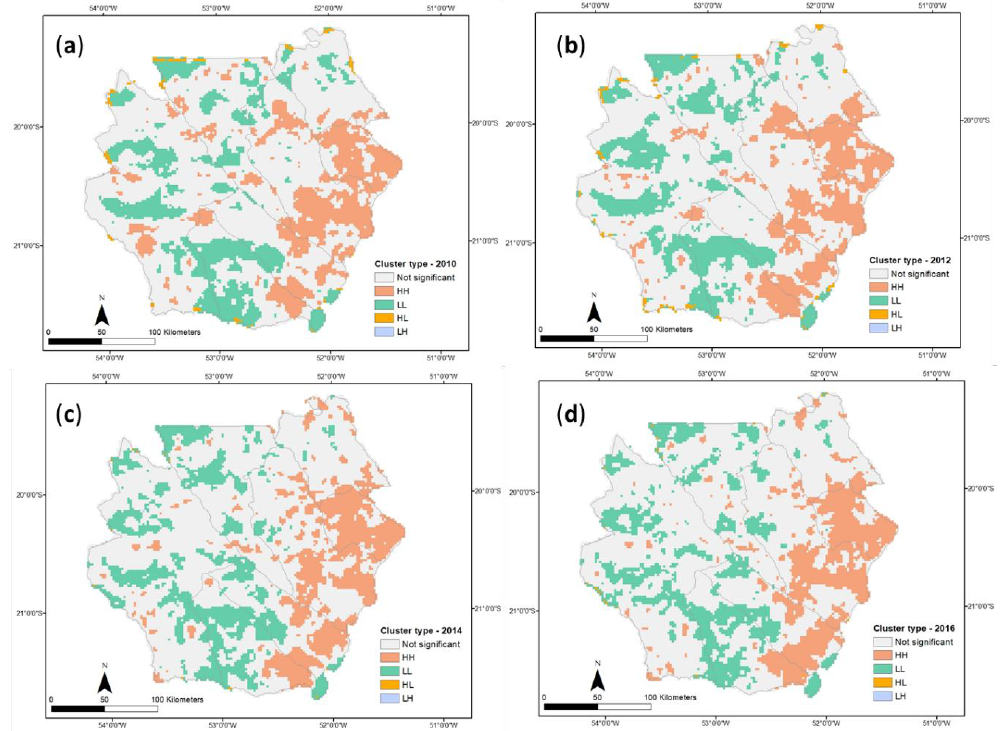
Figure 7. Spatial distribution of the cluster type: Hot Spot (HH), Hot Spot surrounded by Cold Spot (HL), Cold Spot (LL), and Cold Spot surrounded by Hot Spot (LH). ( a ) Cluster´s distribution in 2010 ( b ) Cluster´s distribution in 2012. ( c ) Cluster´s distribution in 2014. ( d ) Cluster´s distribution in 2016.